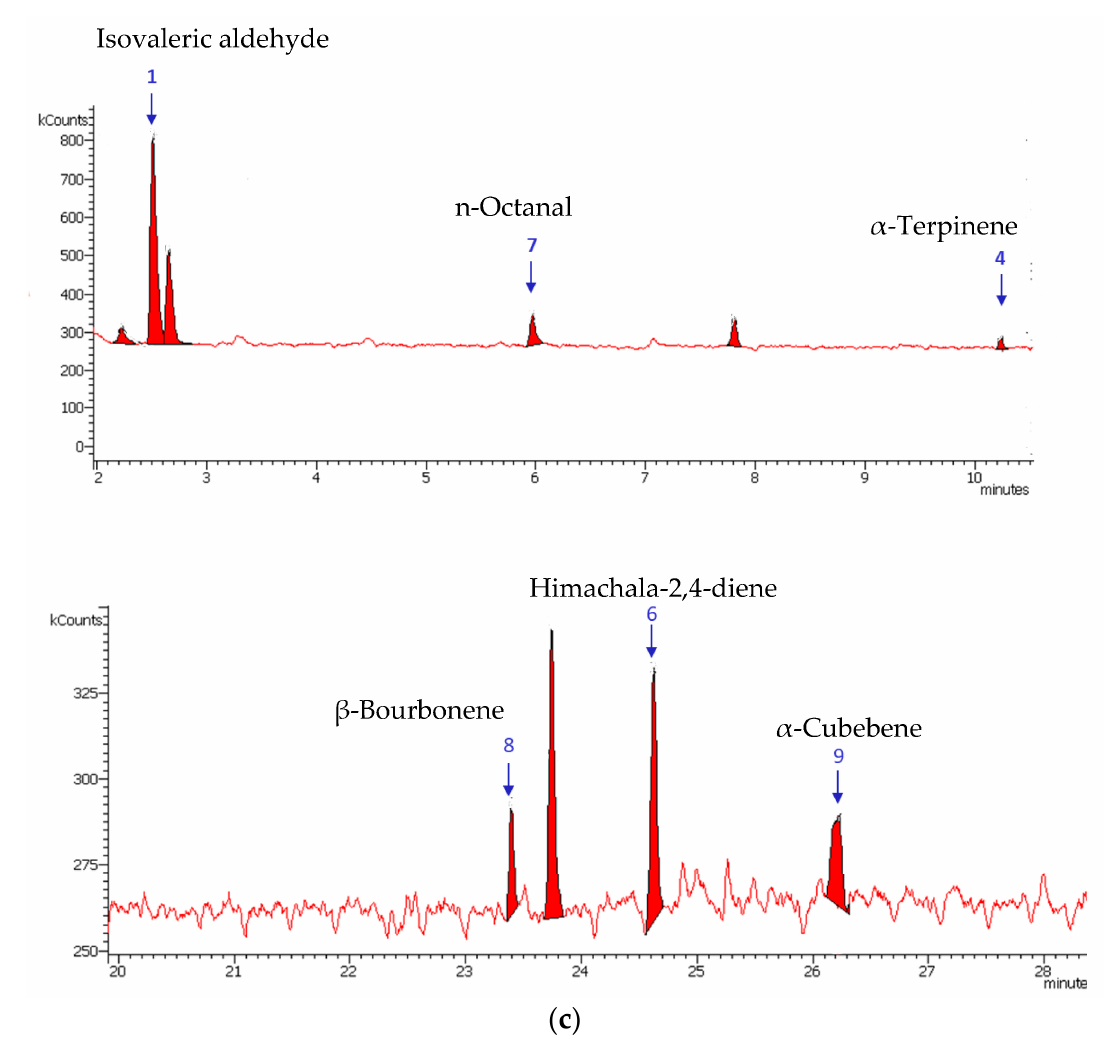
Figure 1. HPLC-MS ( a ) and GC-MS ( b , c ) chromatograms of extracts from leaves ( a and b ) and flowers ( c ) of P. viscosa . The peaks are numbered in the order of compounds listed in Tables 1 and 2. GC chromatograms are presented in several patterns of ca. 10 min in appropriate signal scales. The GC chromatogram of flowers shows patterns of 0–10 min and 20–30 min since at 10–20 min, there were no identified peaks. Table 1. Phytochemicals extracted from P. viscosa and identified by HPLC, LC-ESI-MS and MALDI- TOF-MS.